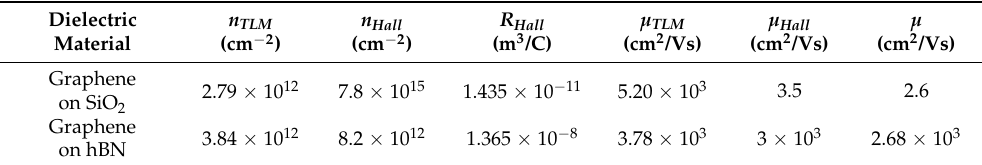
Table 1. Summary of carrier density and mobility from TLM and Hall effect methods on both die- lectric materials.